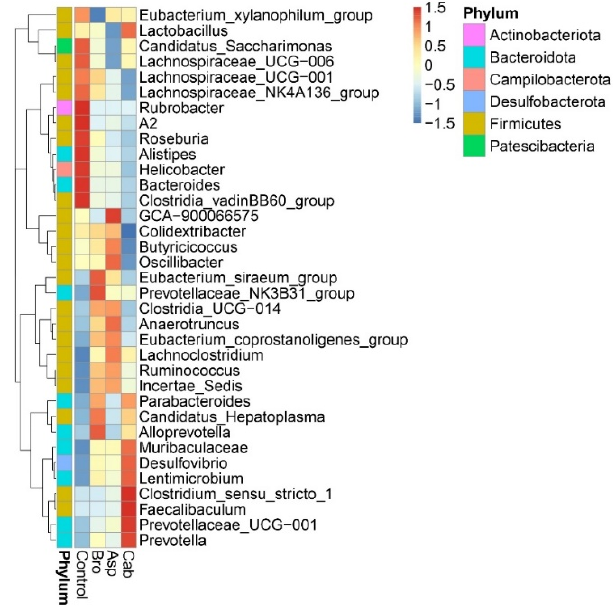
Figure 4. Heat map of intestinal flora abundance in mice.